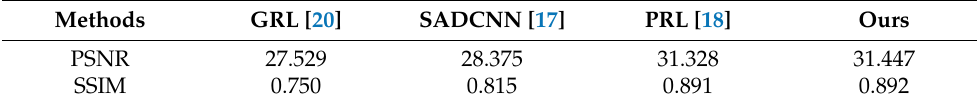
In the model training, the model loss and PSNR values were recorded in Figure 10, where PSNR is the average of 3600 test images.